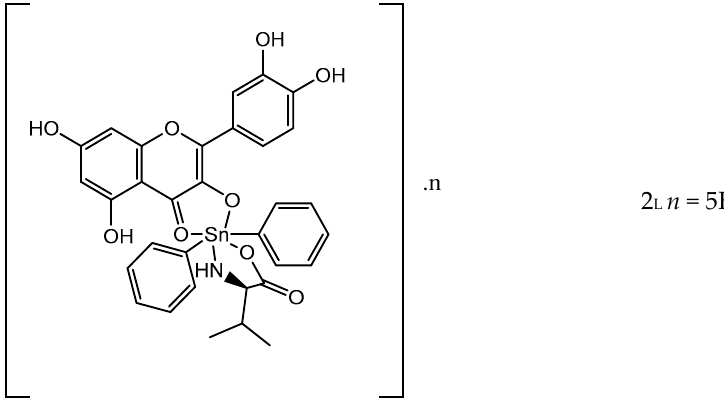
Figure 13. Chemical structure of L-valinequercetin diorganotin (IV) ( 38 ).